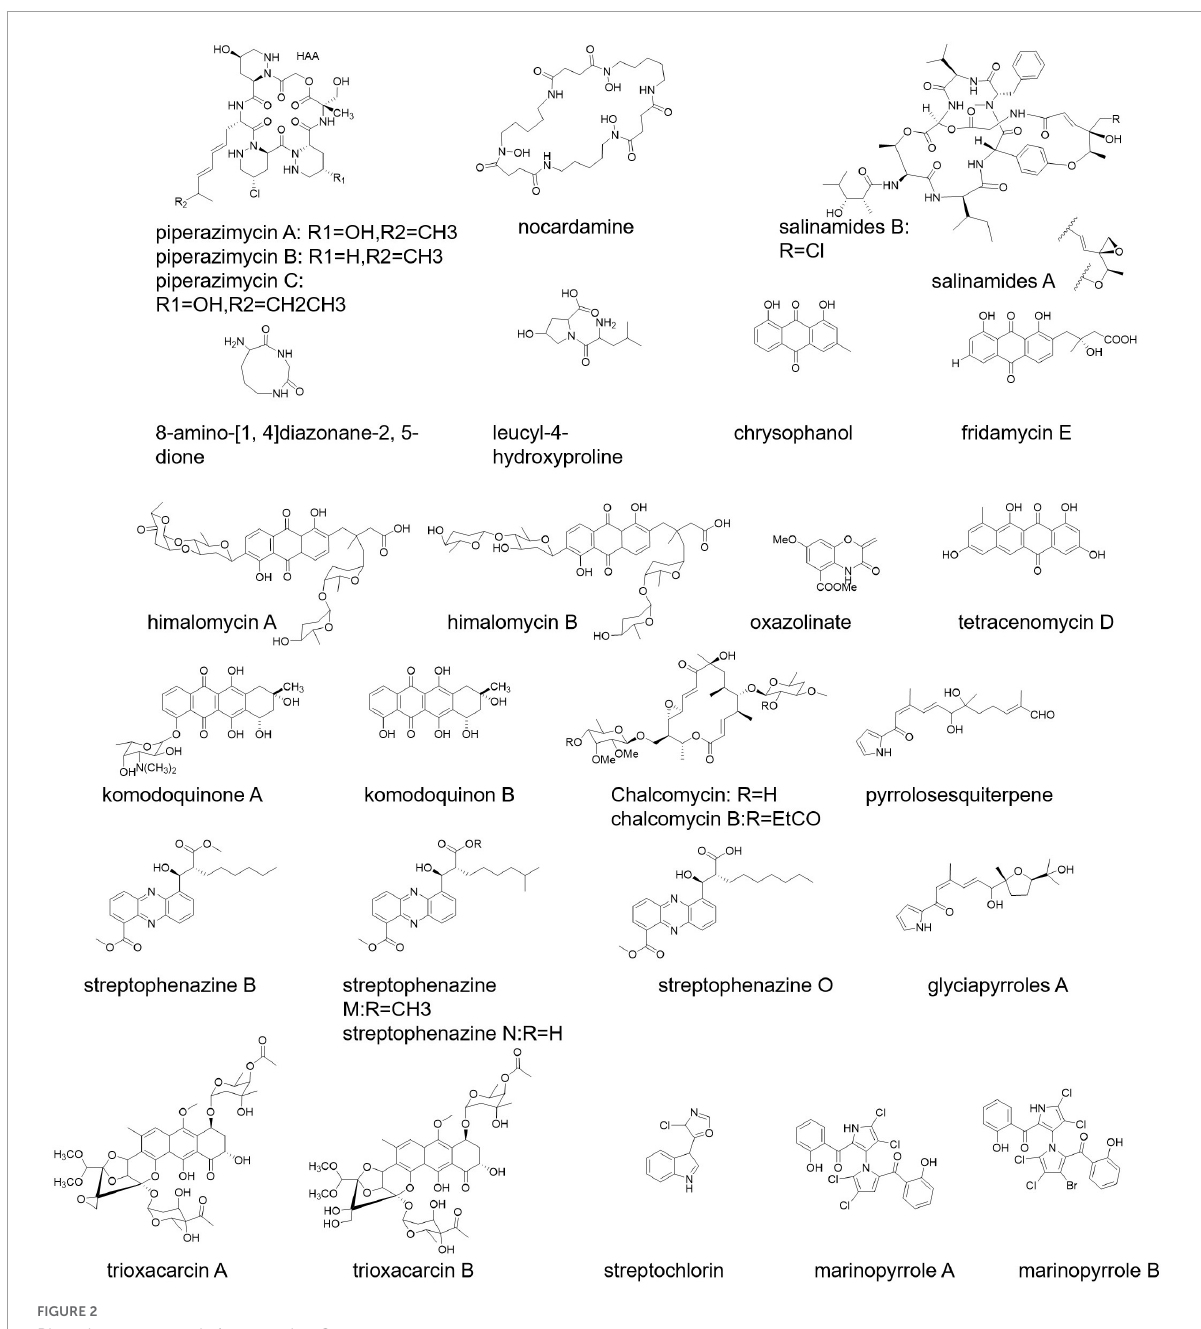
FIGURE2 Bioactive compounds from marine Streptomyces